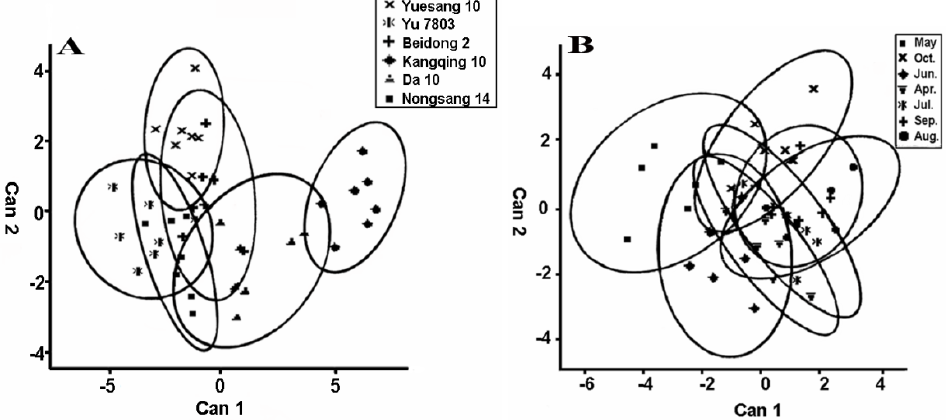
Figure 1. Canonical discriminant analysis of the mulberry cultivars ( A ) and harvest month of mulberry leaves ( B ).